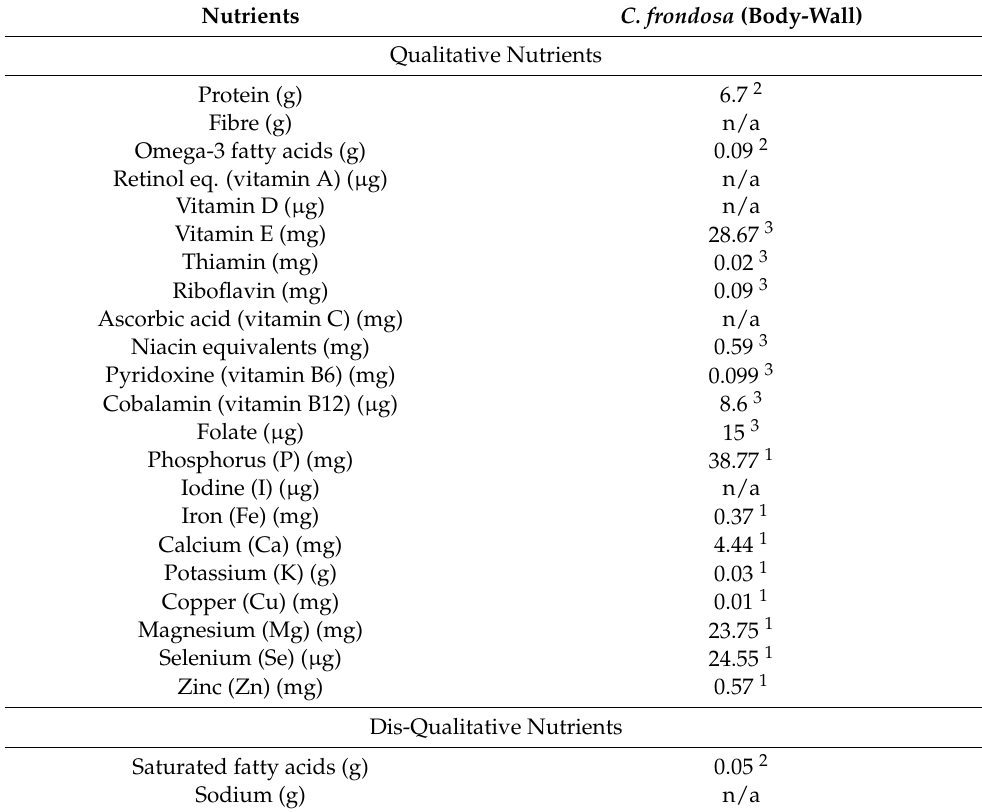
Table 7. Amount of micro- and macronutrients per 100 g wet weight body-wall of orange-footed sea cucumber ( Cucumaria frondosa ). Nutrient categories were adapted from Hallström et al. [21].